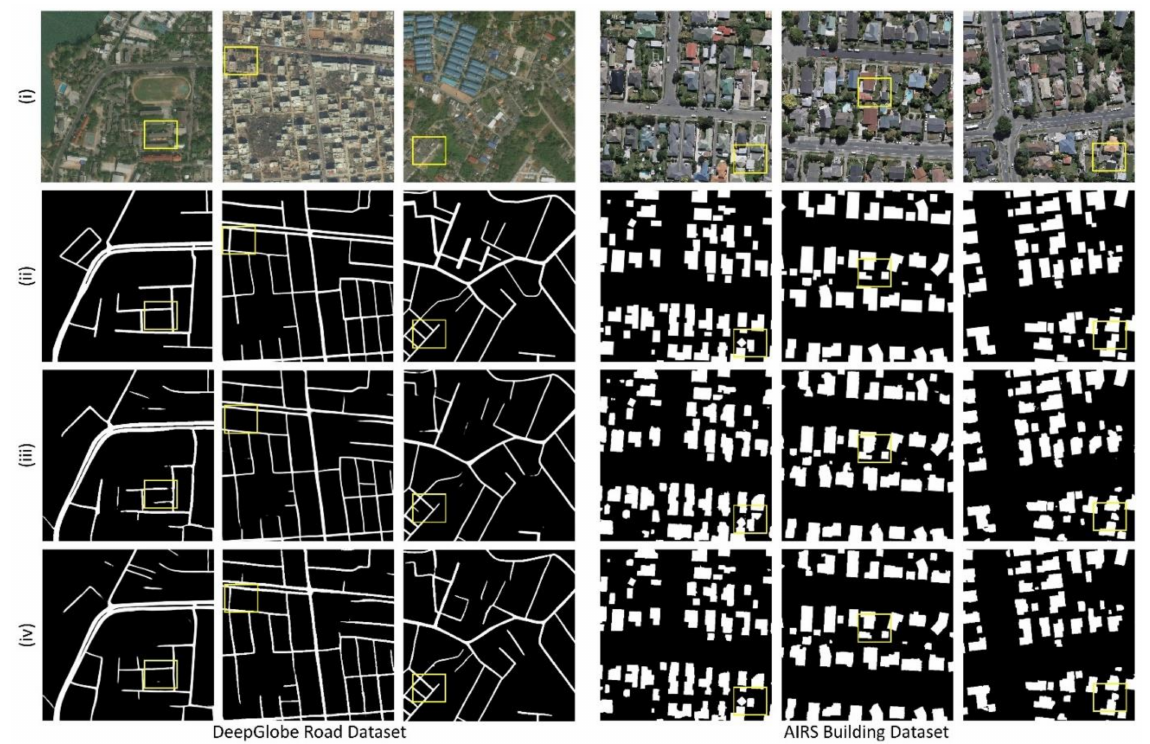
Figure 12. Building and road maps produced by the presented BCL-UNet and MCG-UNet techniques from the AIRS and DeepGlobe datasets. ( i ) Original imagery, ( ii ) ground truth imagery, ( iii ) results of BCL-UNet, and ( iv ) results of MCG-UNet. The yellow boxes present the predicted FPs and FNs.